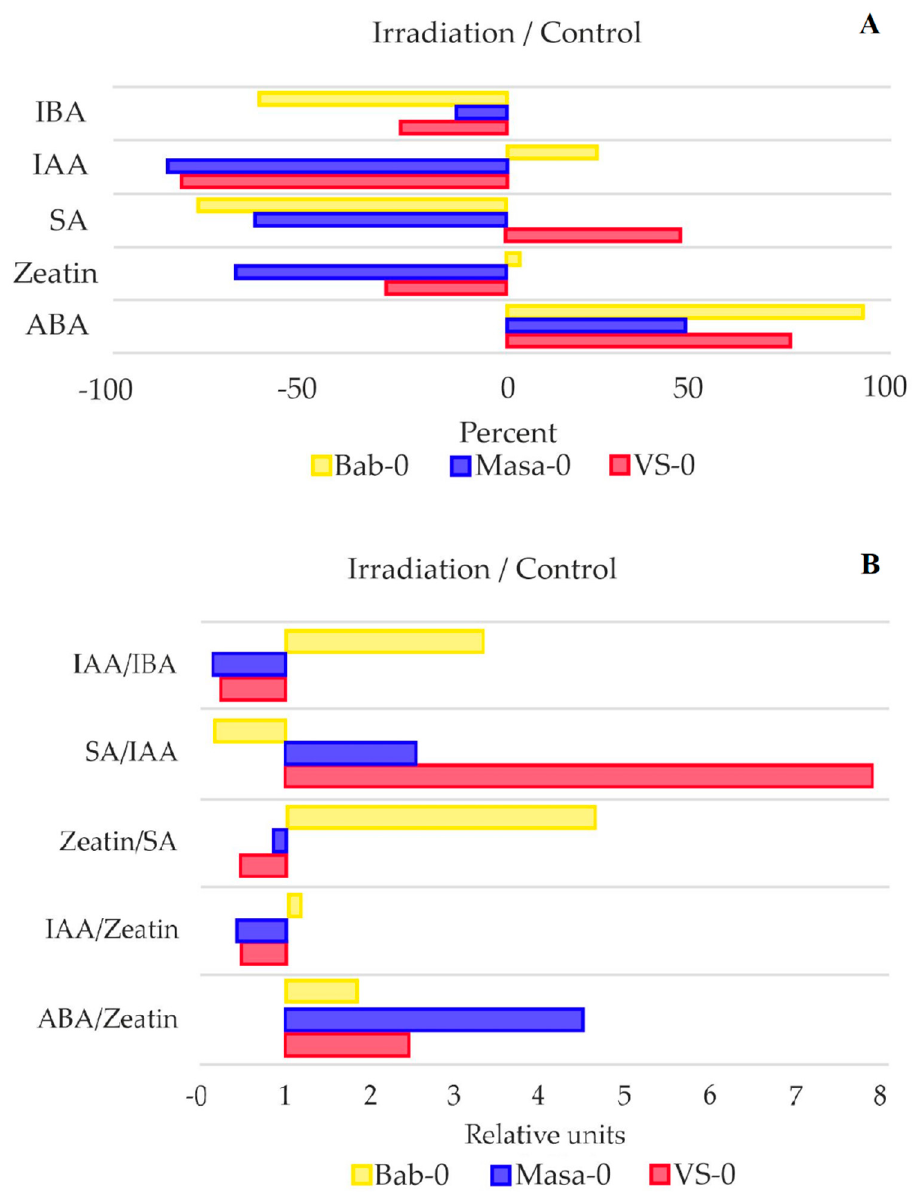
Figure 7. ( A )—Percentage change in phytohormonal content of acutely irradiated plants to control samples (background Bab-0, chronically irradiated VS-0 and Masa-0). Values <0 denote a decrease in the phytohormone concentration, and >0 show an increase as a result of acute γ -irradiation at a dose of 150 Gy. ( B )—Phytohormonal ratios of acutely irradiated samples to the same ratio of control samples (background Bab-0 and chronically irradiated VS-0 and Masa-0). Values <1 denote a de- crease in the phytohormonal ratio as a result of acute γ -irradiation at a dose of 150 Gy, and values >1 show an increase. IBA—indole-3-butyric acid, IAA—indole-3-acetic acid, SA—salicylic acid, ABA—abscisic acid. The graphs were created using RStudio v1.4 (R-Tools Technology, Richmond Hill, ON, Canada).